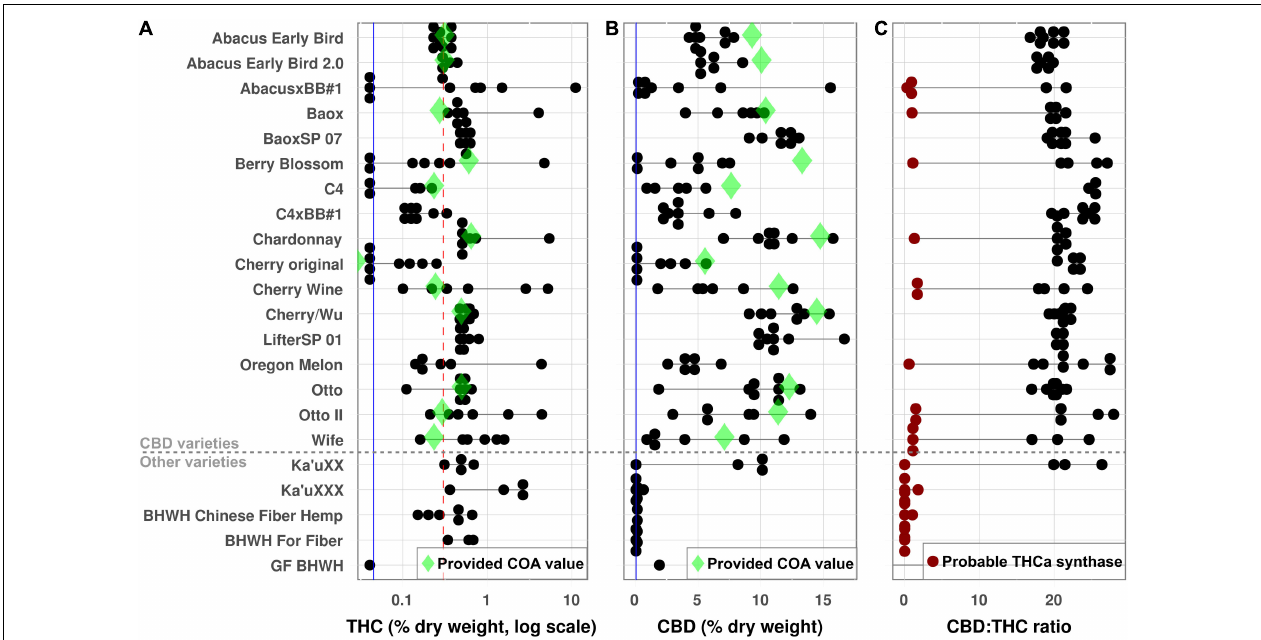
FIGURE 2 | Cannabinoid analysis. THC and CBD were determined for all plants as a percent dry weight of harvested material. Each dot represents a single plant, and horizontal black lines show the range of values for a given accession. Green diamonds show the value provided on the Certificate of Analysis (COA) for each variety, and vertical blue lines show the limit of detection. (A) THC values. The red dotted line is maximum allowable value in the United States (0.3%); plants above this line would be considered marijuana. (B) CBD. (C) CBD:THC ratio. Red dots indicate plants whose measured CBD:THC ratio indicates the presence of at least one active THCa synthase